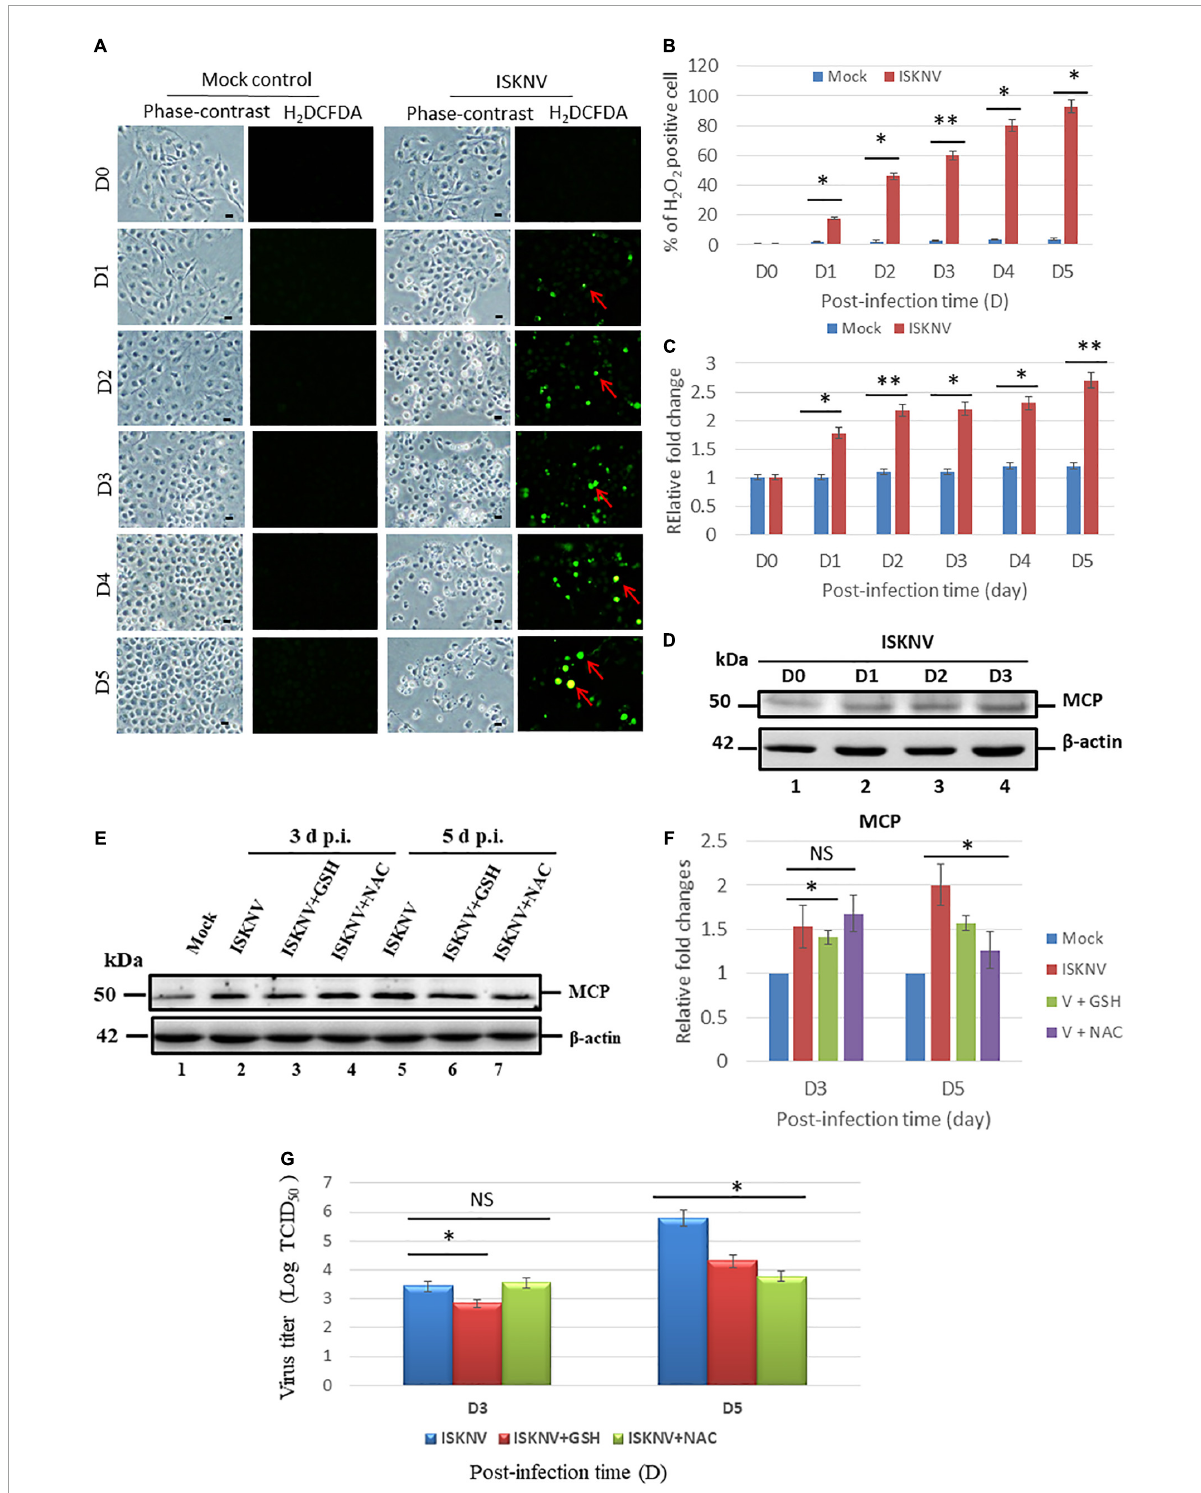
FIGURE1 Infectious spleen and kidney necrosis virus (ISKNV) can induce reactive oxidative species (ROS) production and is correlated with viral replication in fish GF-1 cells. (A) Phase-contrast/green fluorescence micrographs of ISKNV-infected fish cells from day 0 to day 5. Phase contrast images of rounded-up cells were stained with H 2 DCFDA to examine ROS production: positive cells are indicated by red arrows. Scale bar = 10 µ m. (B) Percentage of H 2 DCFD (green fluorescence)-positive ISKNV-infected cells from day 0 to day 5. The quantification of